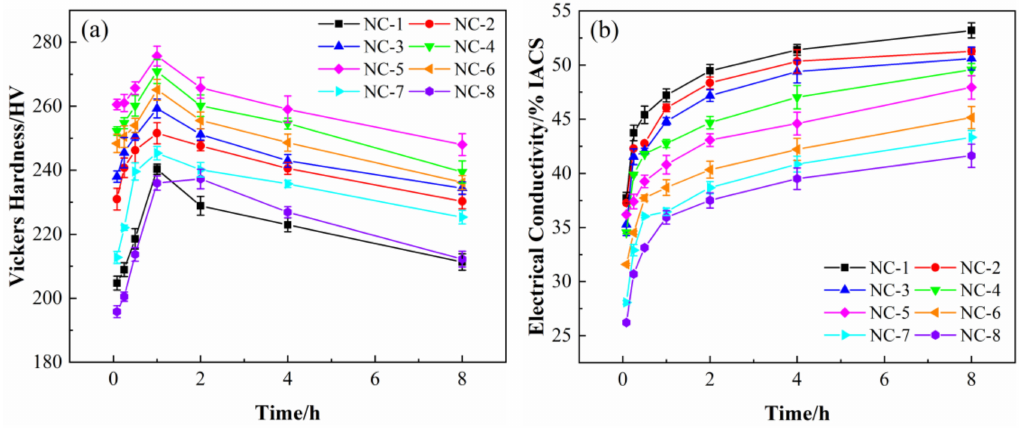
Figure 2. ( a ) Hardness and ( b ) electrical conductivity of alloys aged at 500 ◦ C with di ff erent Ni / Co mass ratios.